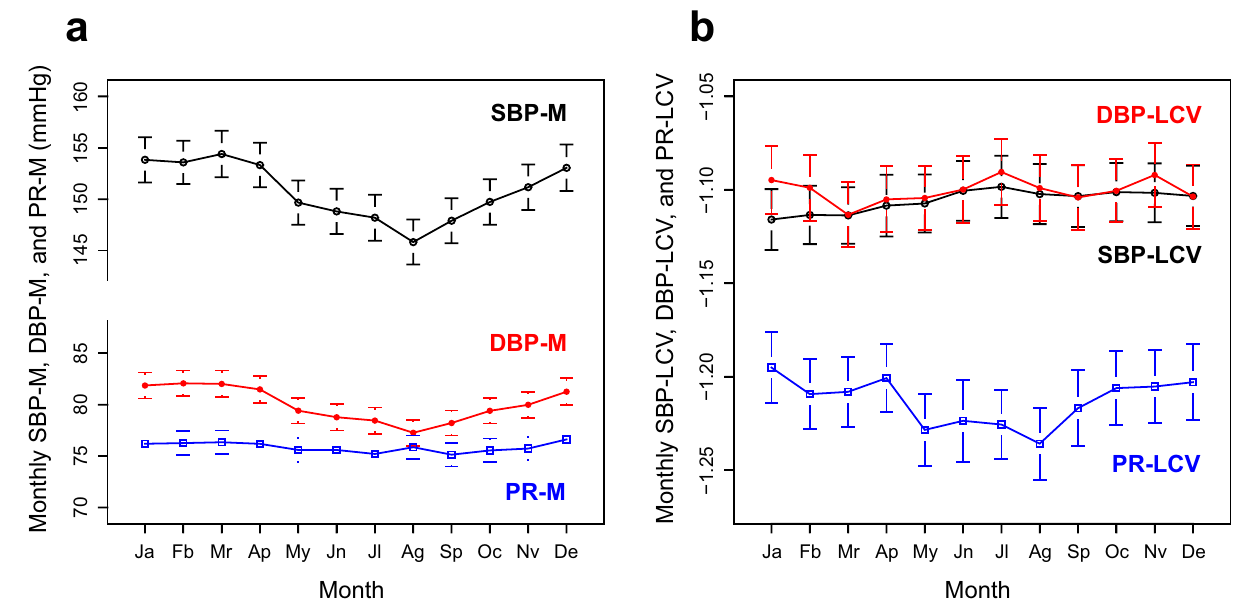
Figure 1. Monthly mean levels and variability of the pre-dialysis blood pressure and pulse rate. SBP systolic blood pressure, DBP diastolic blood pressure, PR pulse rate. The monthly SBP, DBP, and PR measurements were compiled for each patient. The number of eligible patients per month was 331–334. Error bar represents the 95% confidence Comparison of the values for August and February, as representative values for the summer and winter months by the paired t-test showed a highly significant difference. (SBP-M: 153.6 ± 19.6 vs. 145.8 ± 20.3, P < 10 –16 ; DBP- M: 82.1 ± 11.6 vs. 77.3 ± 5.9, P < 10 –22 ). On the other hand, the monthly means of the PR for these months were